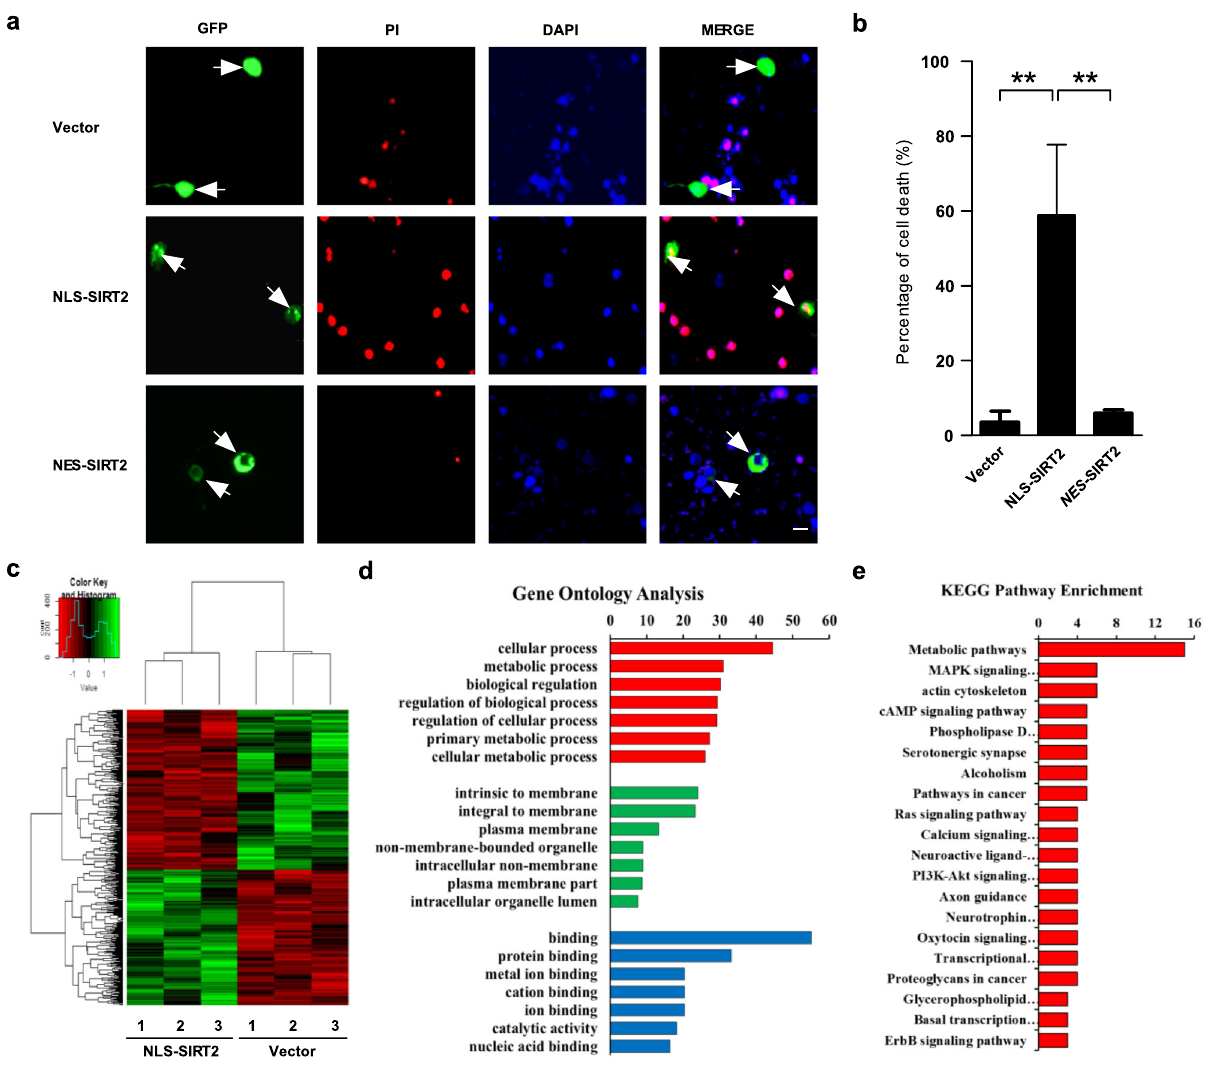
Fig. 4 Nuclear localization of SIRT2 promotes neuronal death. a Primary culture neurons were transiently transfected with GFP vector or GFP-NLS-SIRT2 plasmids and subsequently stained using anti-SIRT2 antibodies (green), propidium iodide (PI) (red), and DAPI (blue). The scale bar represents 10 μ m. b GFP-positive cells (green) that also showed positive PI staining (red) were counted as dead neurons. The percentage of PI-positive cells (red) among at least 100 GFP-positive cells was measured for each group ( n = 3). All data are presented as the means ± SD. Statistical analyses were conducted using one-way ANOVA followed by Tukey ’ s post hoc test, and ** represents P < 0.01. c HEK293 cells were transfected with GFP vector and GFP-NLS-SIRT2 plasmids for 24 h and subsequently collected for RNA-seq. The differentially expressed genes between the two groups are illustrated using a heatmap ( n = 3). The colors indicate relative expression levels (red, high expression; green, low expression). d Gene Ontology (GO) terms. Frequency of sequences with assigned GO terms for the biological process category across the different samples. e KEGG pathway enrichment. Biological pathways associated with the differentially expressed genes in the different